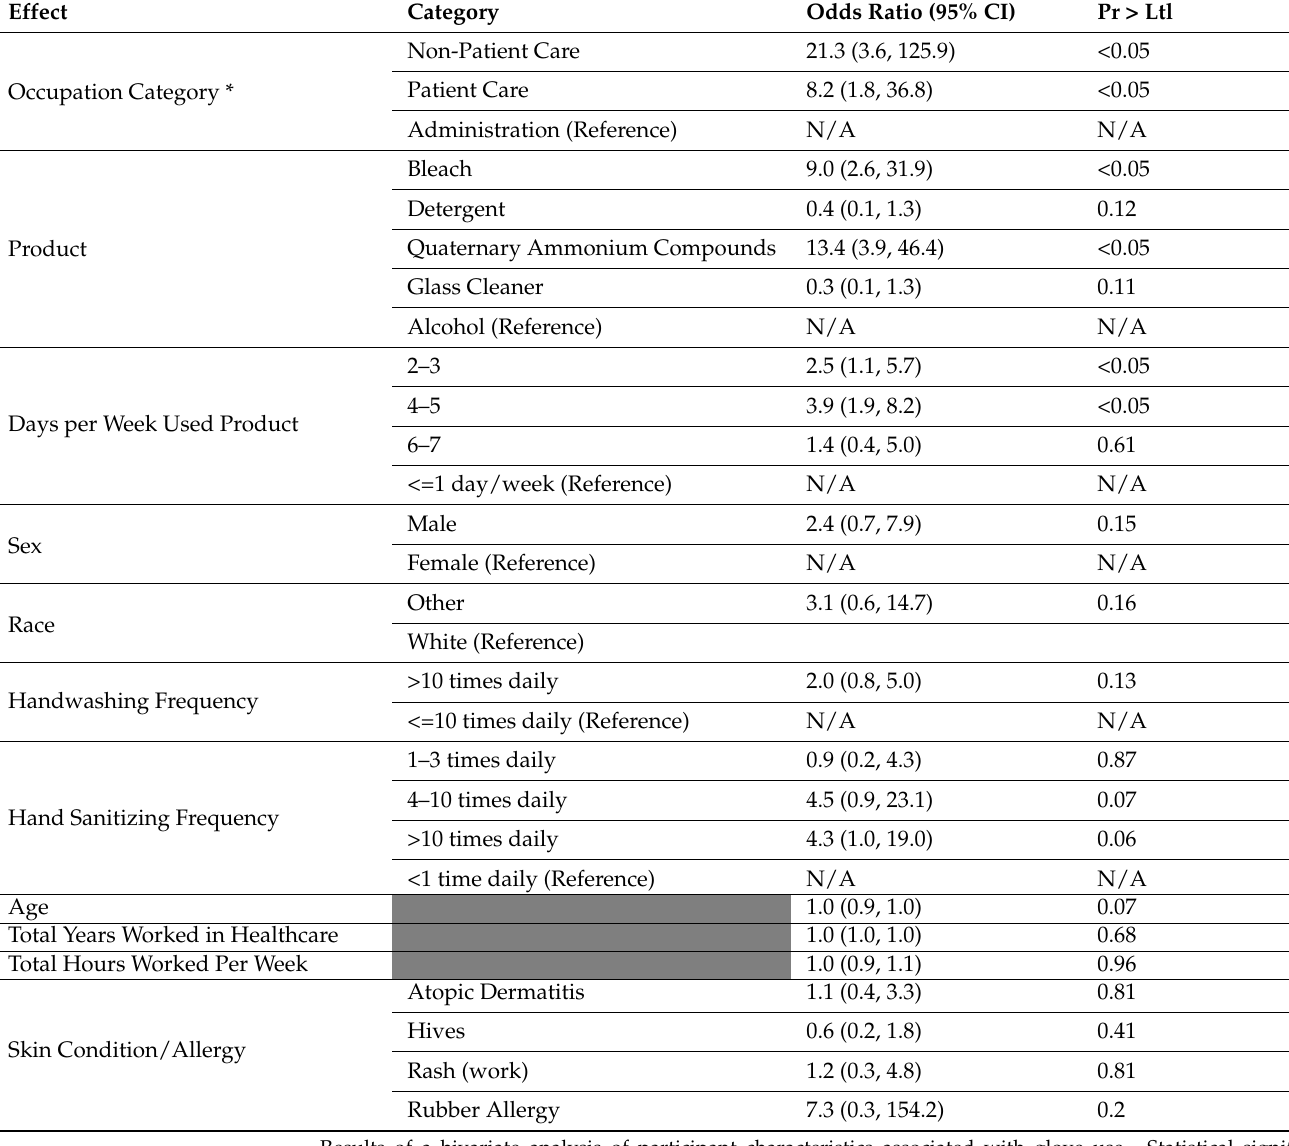
Table 5. Univariate models of glove use against participant characteristics/hand hygiene practices.